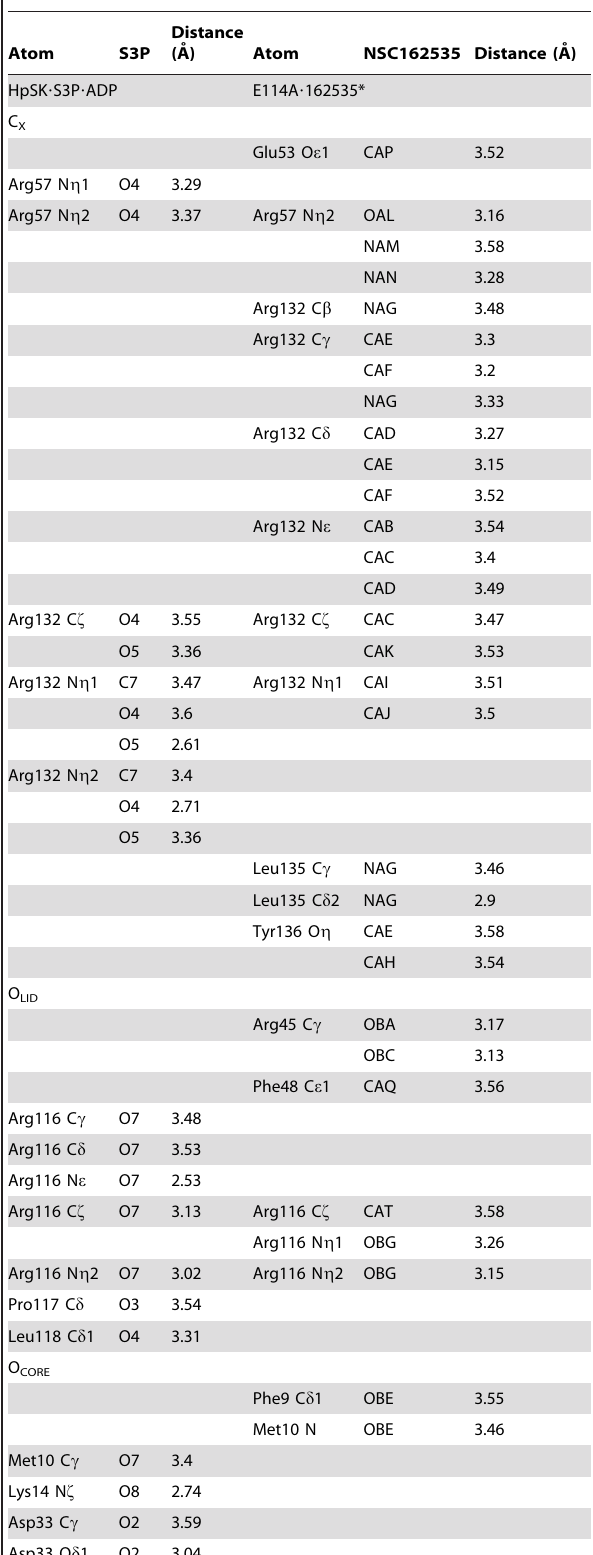
Table 3. Binding of shikimate-3-phosphate and NSC162535 to HpSK ? S3P ? ADP and E114A ? 162535.